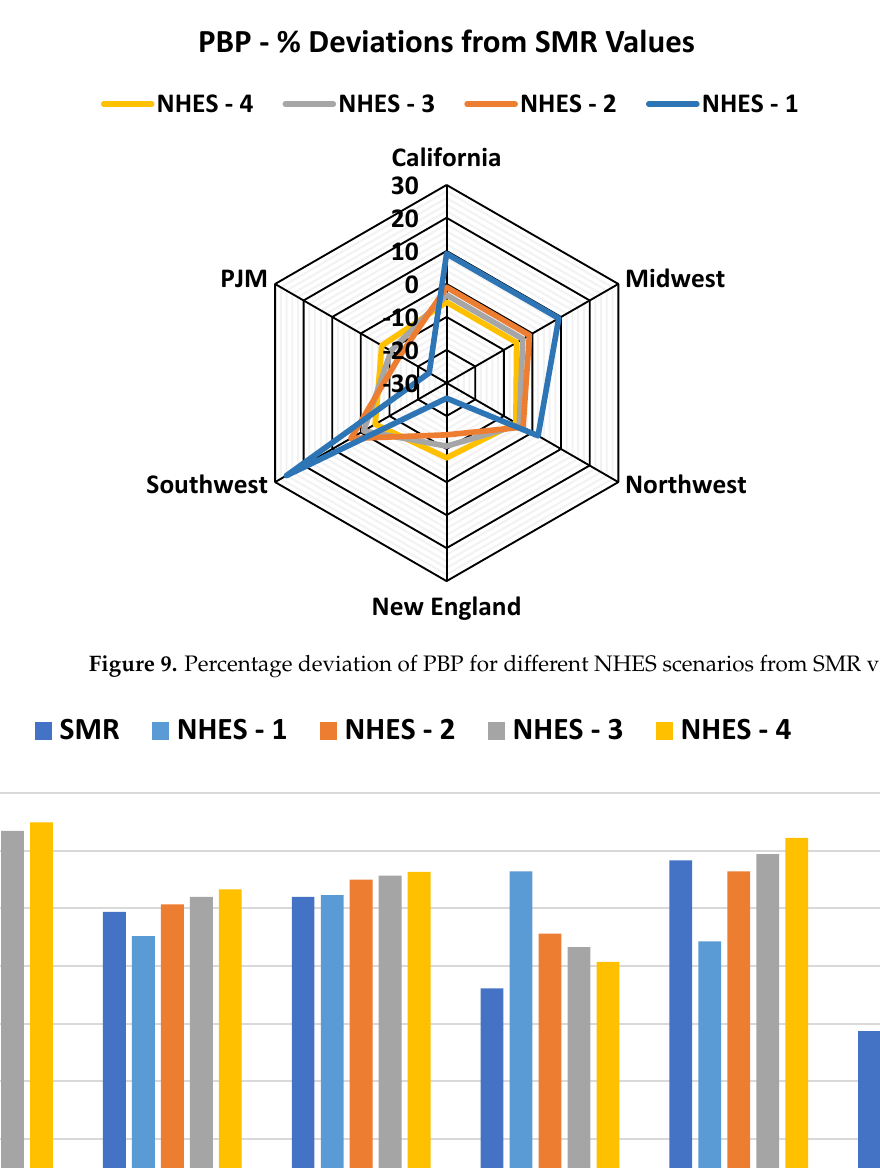
Figure 8. PBP at different regions for SMR and different SMR-ChHP output scenarios .